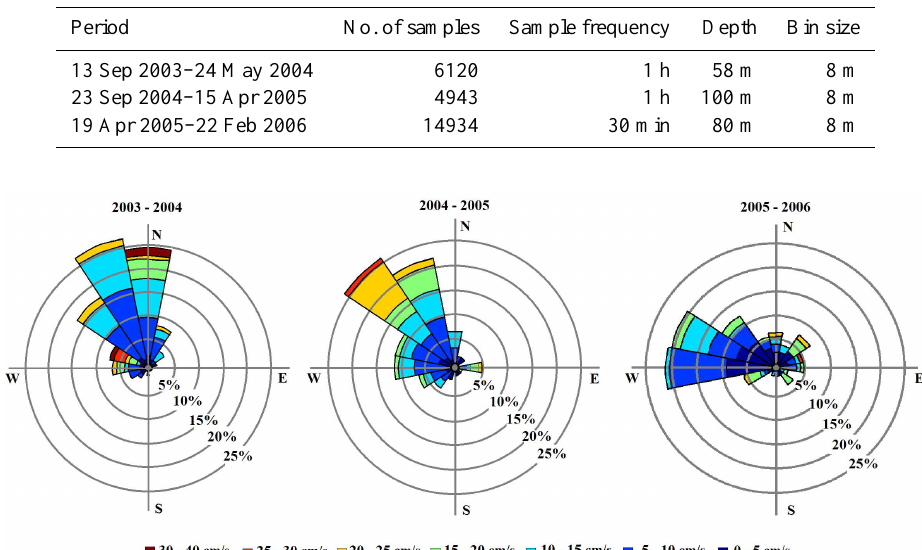
deed pitch and roll data never exceeded 2.5 ◦ , well below the 9 ◦ limit defined by the manufacturer for tilt